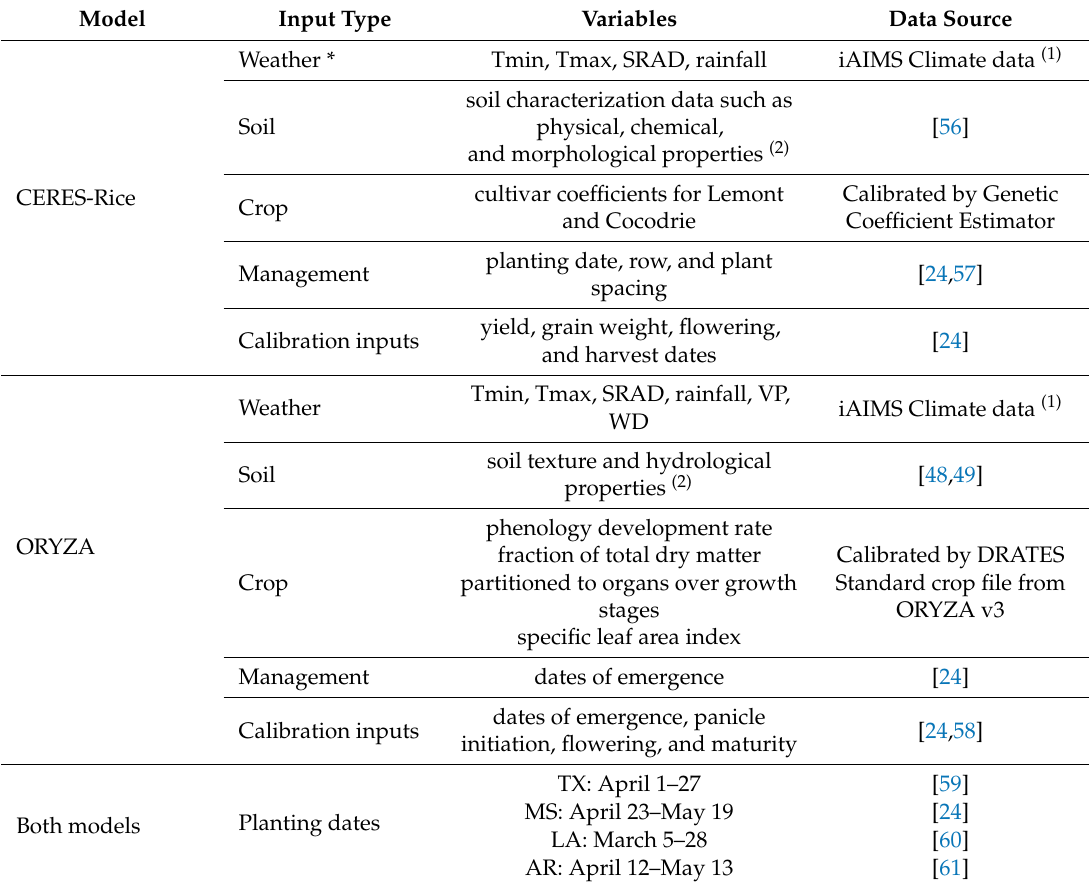
(1) https: // beaumont.tamu.edu / climaticdata / StationInventory.aspx?index = Inventory. (2) Two di ff erent soil data sources were used for CERES and ORYZA in order to provide values needed for the type of soil input data for each model. * Abbreviations: Tmin: minimum temperature ( ◦ C). Tmax: maximum temperature ( ◦ C). SRAD: